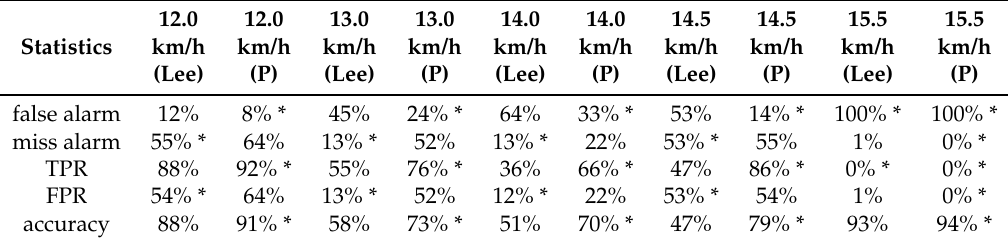
Table 5. Results of binary classification on step, with respect to the statistical parameters (false alarm, miss alarm, TPR, FPR, and accuracy) for the two approaches: Lee (Lee) and proposed (P), at different speeds. The best values for each row and for each pair of columns are highlighted with the symbol *.